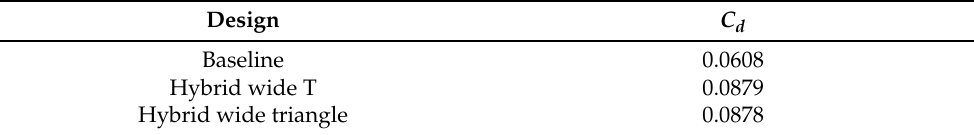
Table 6. Value of drag coefficient, normalized using the WSA for select designs.